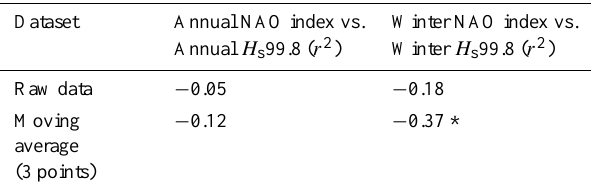
Table 3. NAO index and extreme wave height percentile correla- tions, using different periods (Annual,